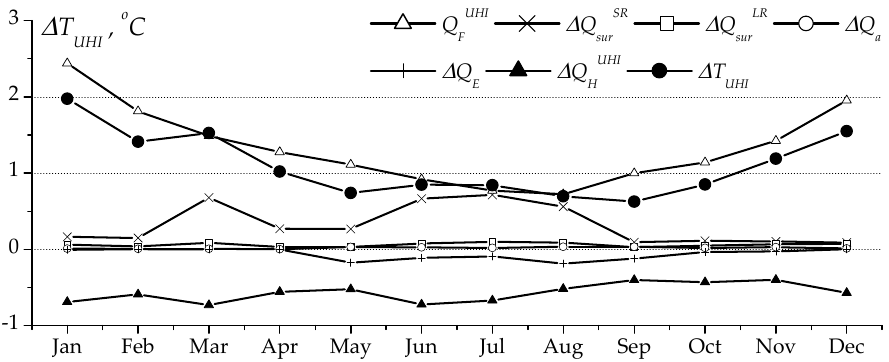
Figure 7. Air temperature increment in the city due to all the heat fluxes.